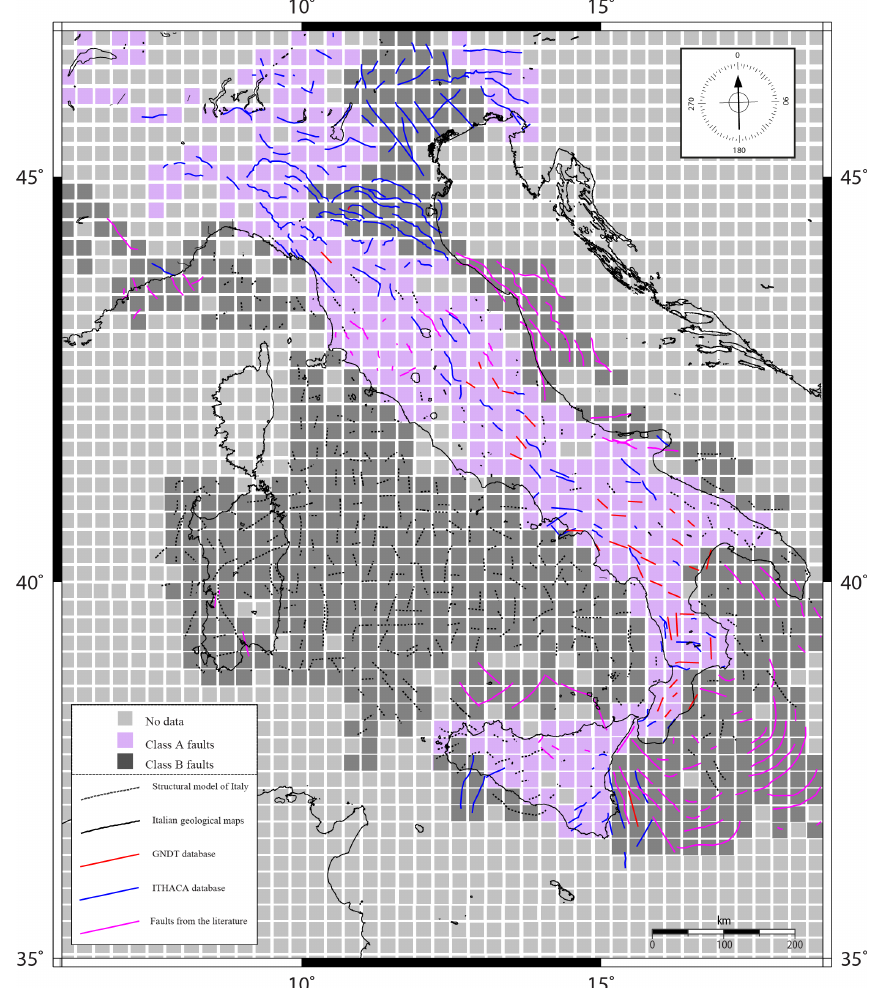
Figure 5. Map of the Italian territory divided into a grid with 25km × 25km square cells. The map also shows the longest faults (from the analysed datasets) falling into each cell. Light purple cells are for class A faults, whereas dark grey cells are for class B